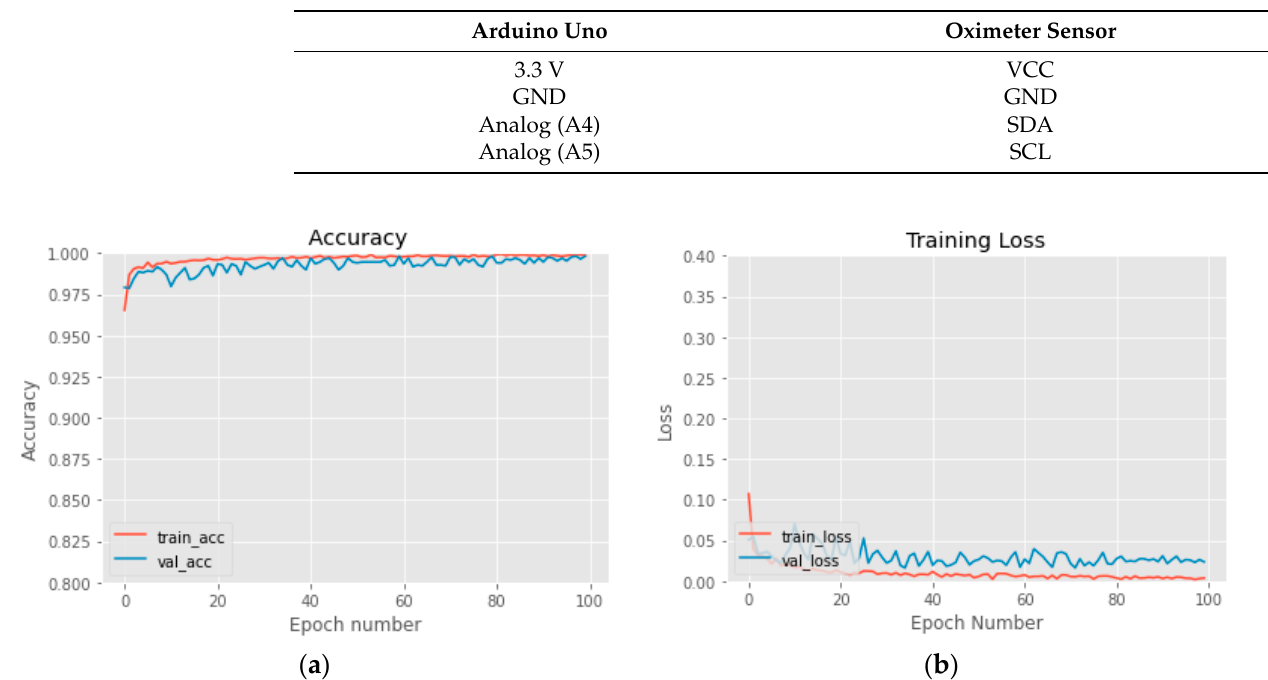
Figure A1. Accuracy ( a ) and loss ( b ) of the proposed model per epoch.